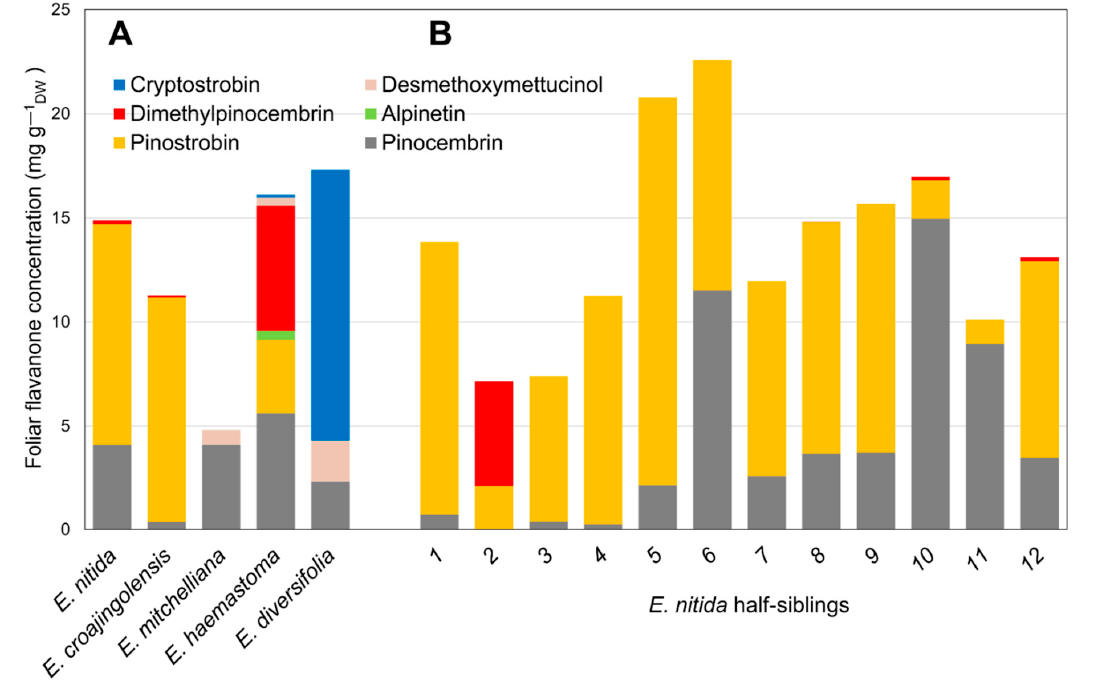
Figure 2. Foliar flavanone profiles of sapling cohorts of Eucalyptus species growing in a trial plantation. ( A ) Average data from 12 half-sibling saplings of 5 selected species; ( B ) individual data from half-siblings of E. nitida , the species chosen for transcriptome sequencing.